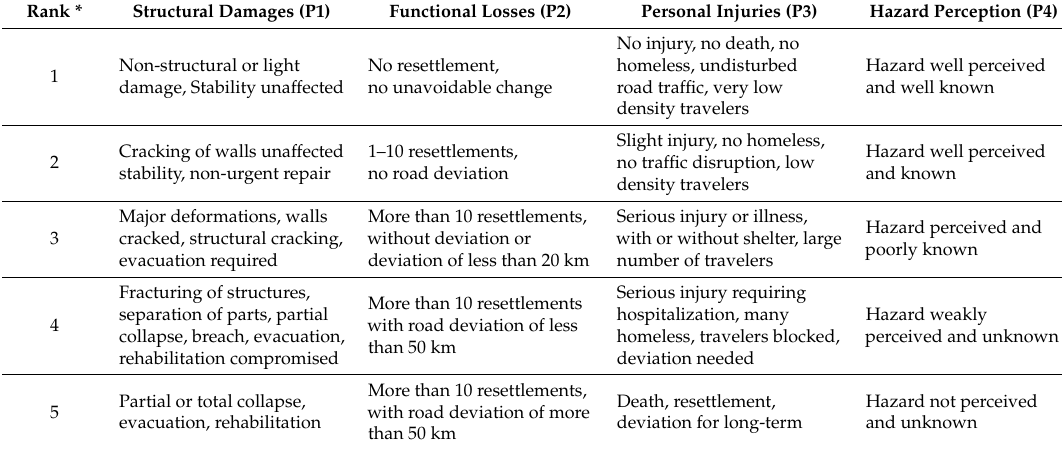
Table 1. Main components and ranking of the vulnerability.